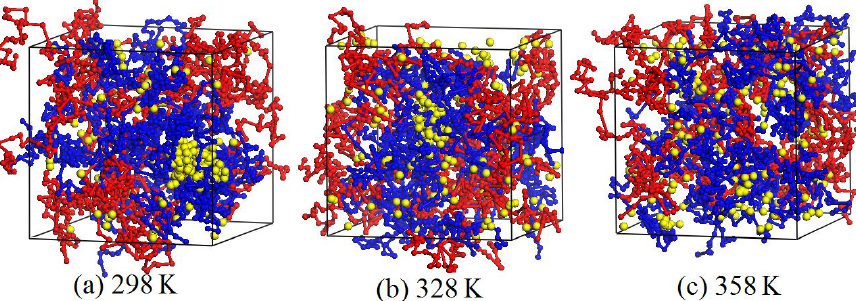
Figure 12. Equilibrated morphologies of 10% PVA/10% PAM/2% nano-silica blended hydrogels at a temperature of ( a ) 298 K; ( b ) 328 K; and ( c ) 358 K.